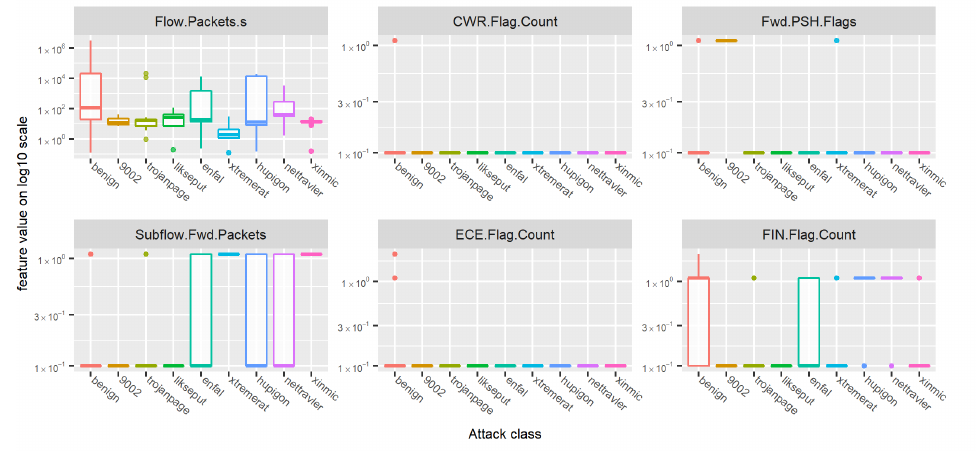
Figure 8. Boxplots for different features—part 4.